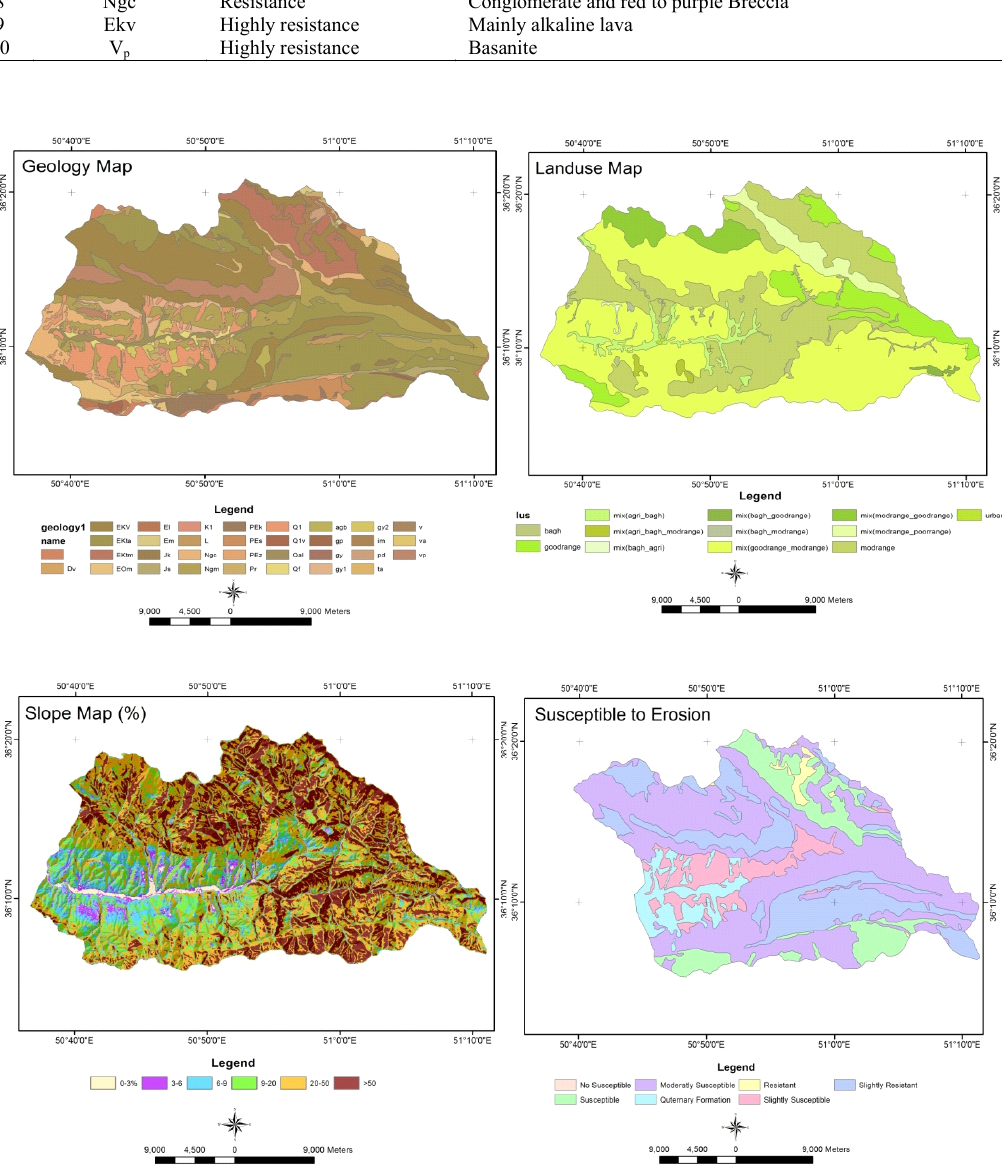
Fig. 6: Maps of geology, slope, erosion, and land use land cover of Taleghan Basin, as four influential factors on sedimentation rate in Taleghan